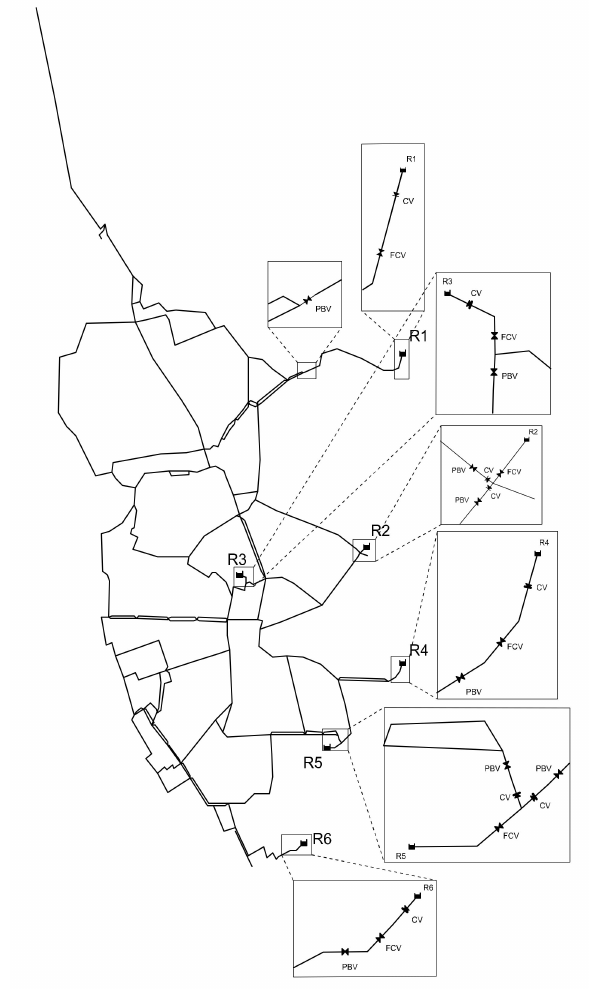
Figure 8. Layout of the simulated Kaohsiung, Taiwan system. The total water consumption of the system is 1.28 million m 3 /day for domestic